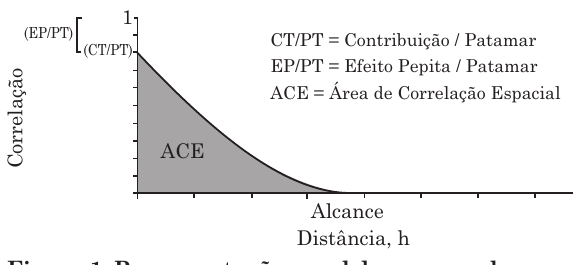
Figura 1. Representação geral de um correlograma, seus parâmetros e a área de correlação espacial